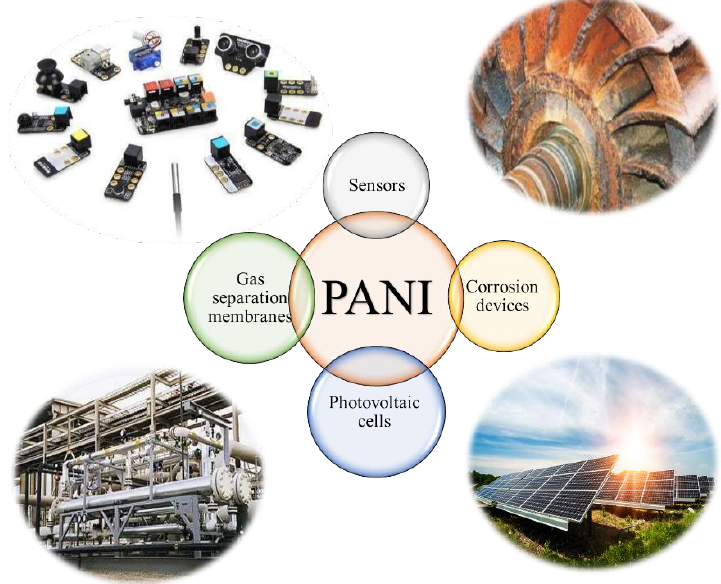
Figure 1. Polyaniline in different applications.